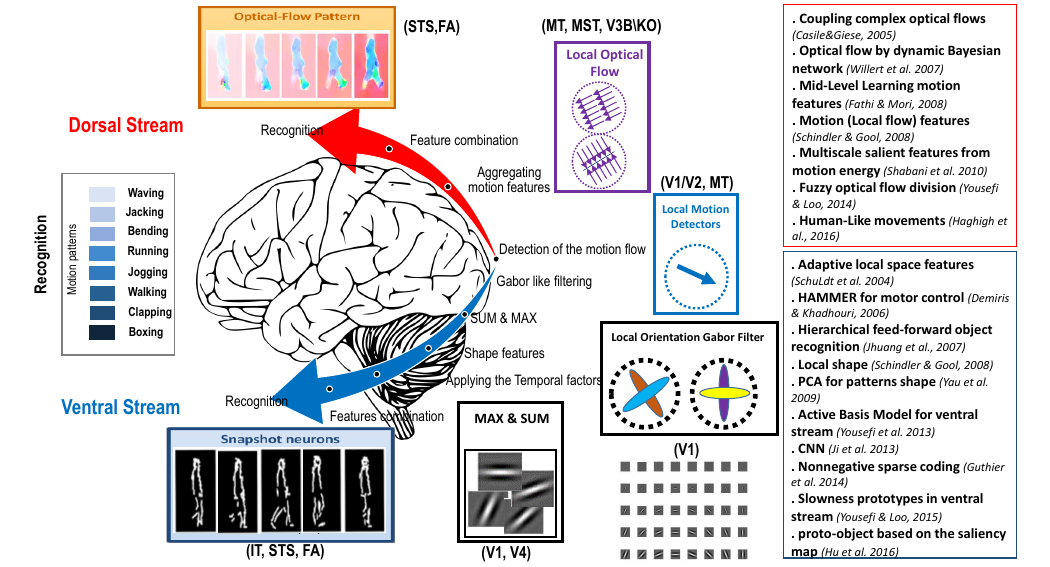
Figure 7. A brief visual representation of some important approaches in modifying computational model for human action